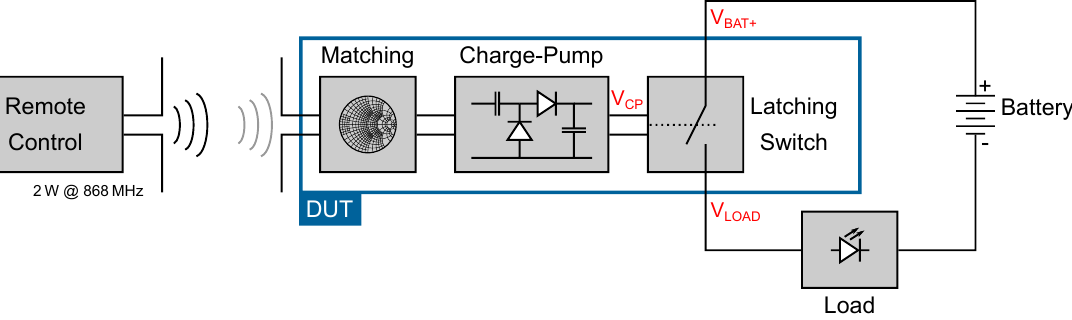
Figure 1. Schematic representation of the proposed remote control